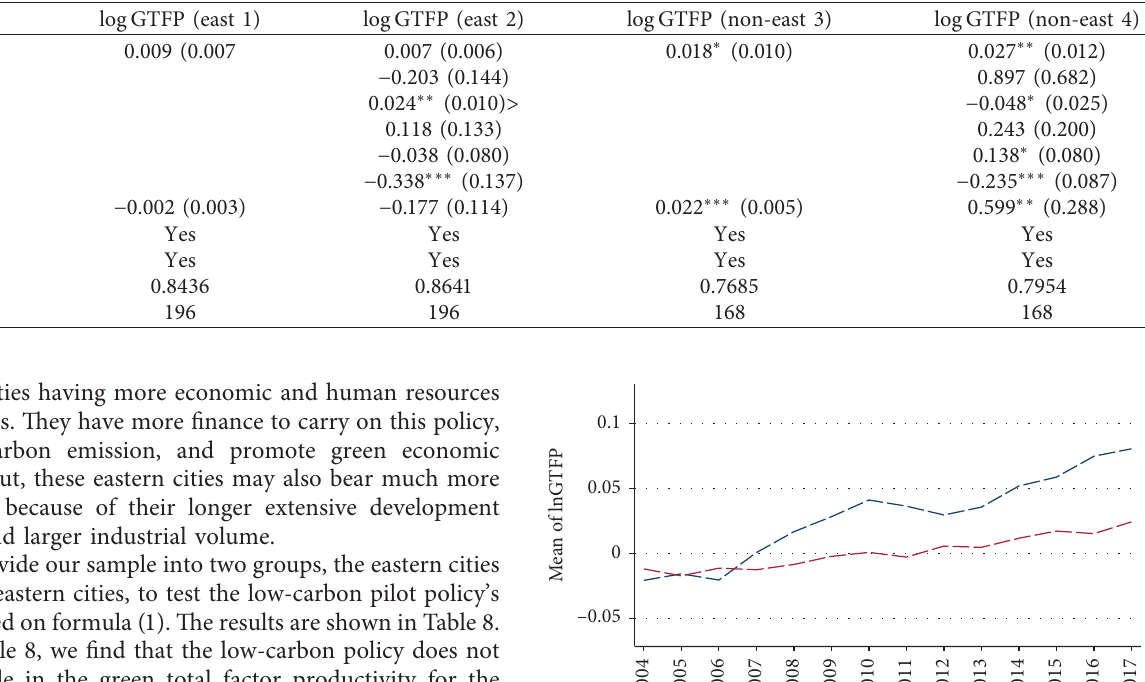
Table 8: Eastern and non-eastern cities’ low-carbon policy effect.